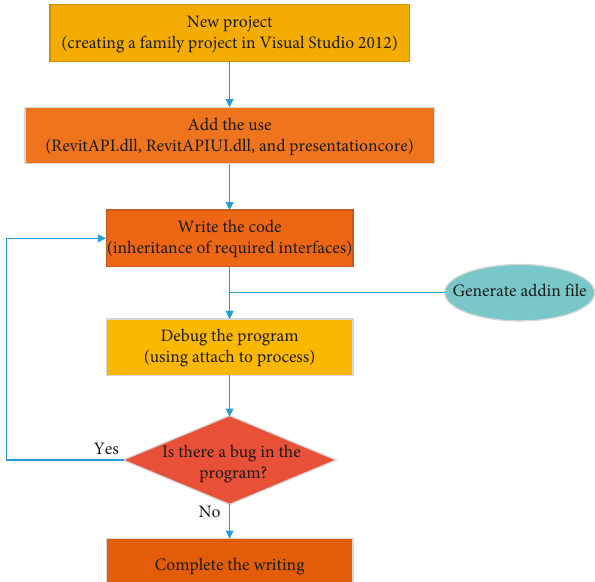
Figure 2: Revit secondary development